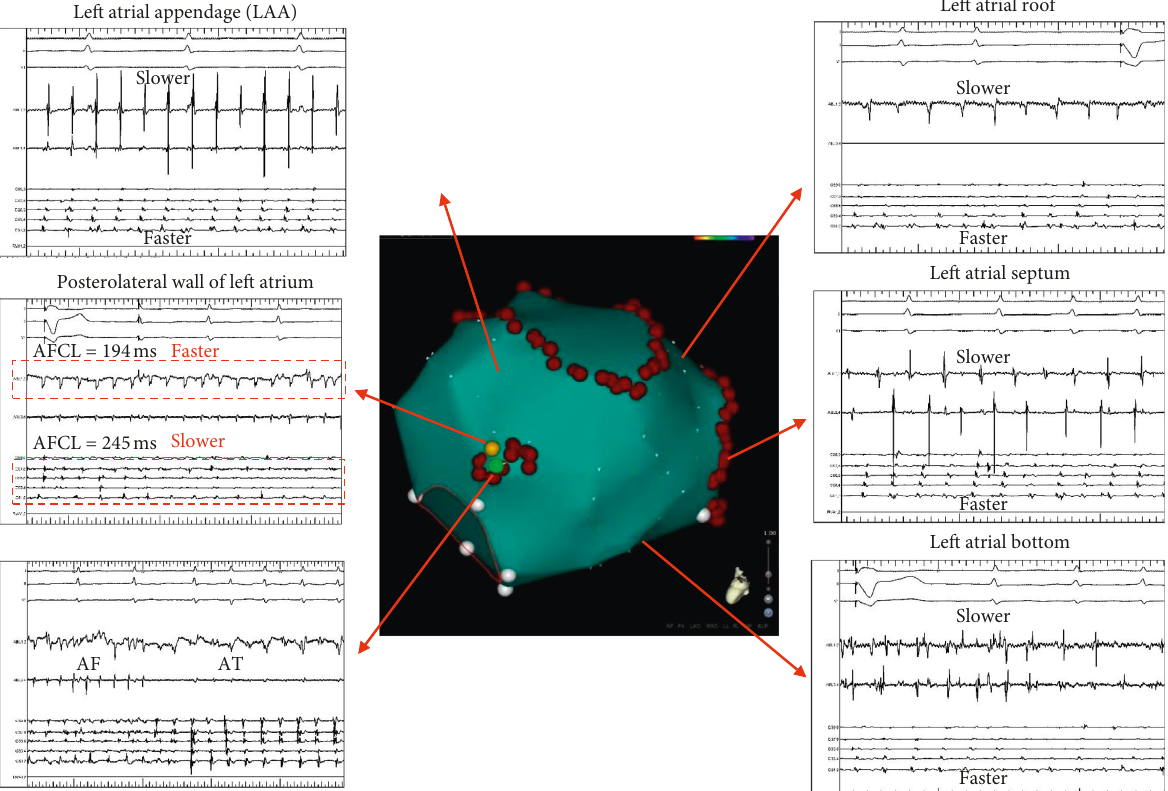
Figure 4: Ablation of the site with the most rapid atrial fibrillation cycle length (AFCL) uncovered by low-dose ibutilide administration terminated persistent AF. The middle figure is the 3D electroanatomic map of the left atrium (LA) in this patient. The red points represent the lesions surrounding the PV antrum. After administration of 0.25mg ibutilide, the LA activity became organized, and the AFCL could be measured at most of the sites in the LA. From top to bottom on the right panel are the intracardiac recordings (abl) from the LA roof, septum, and bottom. The activity at these sites and in the LA appendage (left upper) was longer than that in the coronary sinus. However, the AFCL at the posterolateral aspect of the LA (left middle, yellow point) was significantly shorter than that in the CS (194 vs 245ms), suggesting that this area was harboring an AF driver. During regional ablation of this small region, AF converted to atrial tachycardia (AT, green point).